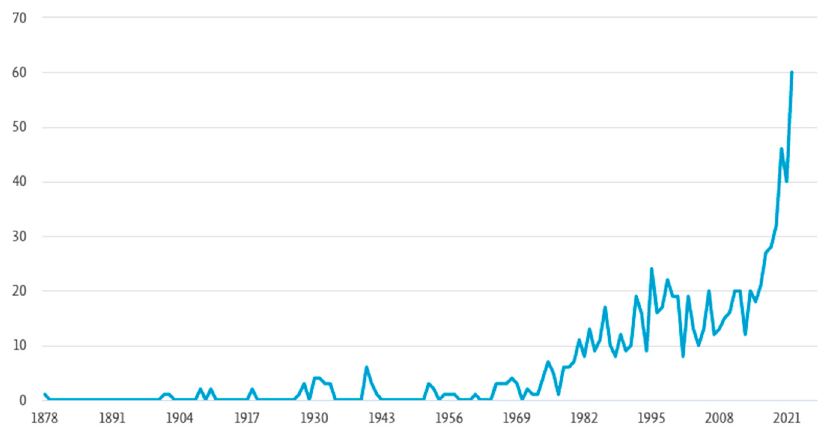
Figure 4. Number of publications per year (ordinate and abscissa axes, respectively) devoted to polyiodides (19 December 2022; Scopus database, search TITLE-ABS-KEY (polyiodide *)—864 examples).